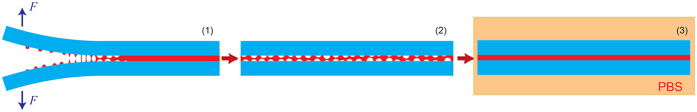
Schematic of healing and deformation process.Schematic illustrating the crack propagation and healing process for a soft self-healing interface. (1) During propagation voids nucleate in front of the crack tip, these voids generate polymer bridges linking the substrates and providing a toughening mechanism. (2) Upon closure the voids generate microscopic defects. (3) When using PBS layers, spreading of the polymer rebuilds a dense interface with properties similar to the original one.